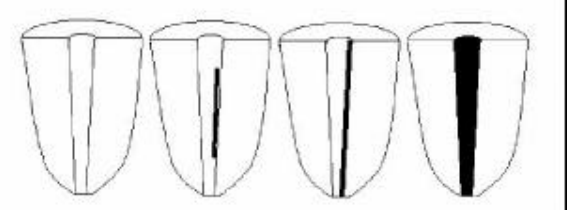
FIGURA 1- Escores da remoção de corante: 0 - sem corante; 1- pequena área de corante em uma das paredes